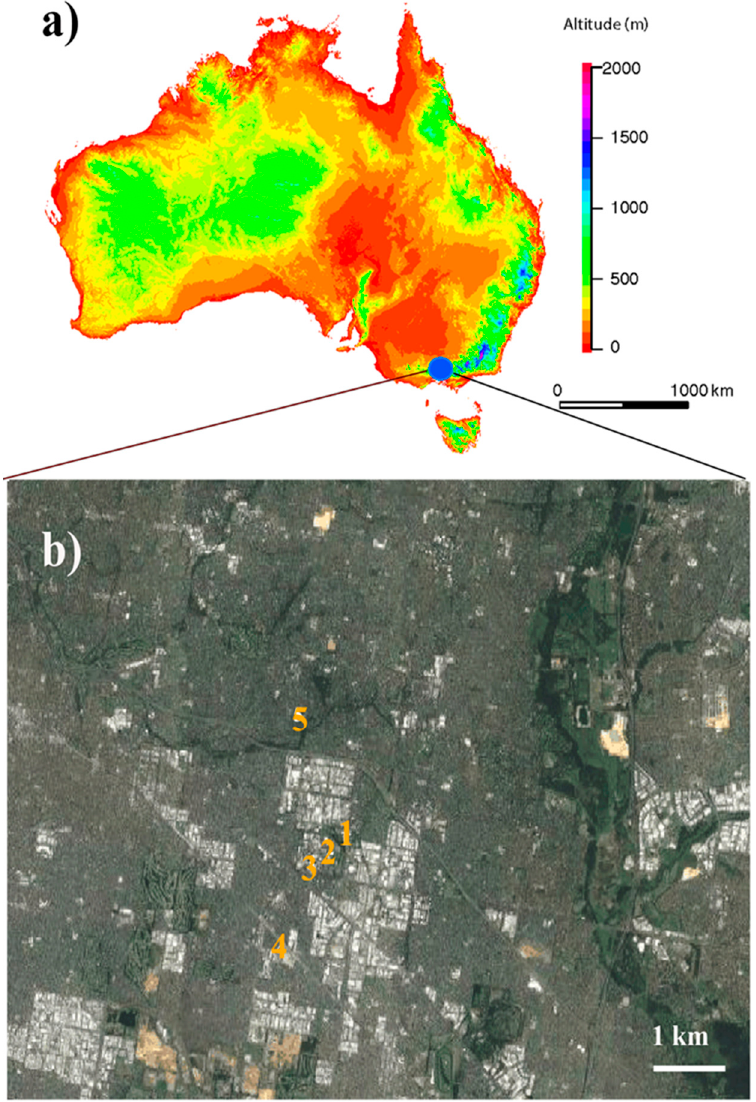
Figure 1. A map of the study area: ( a ) Map of Australia showing the geographical location of the study sites (blue solid circle) and ( b ) the numbers on the map show the sampling locations at Monash